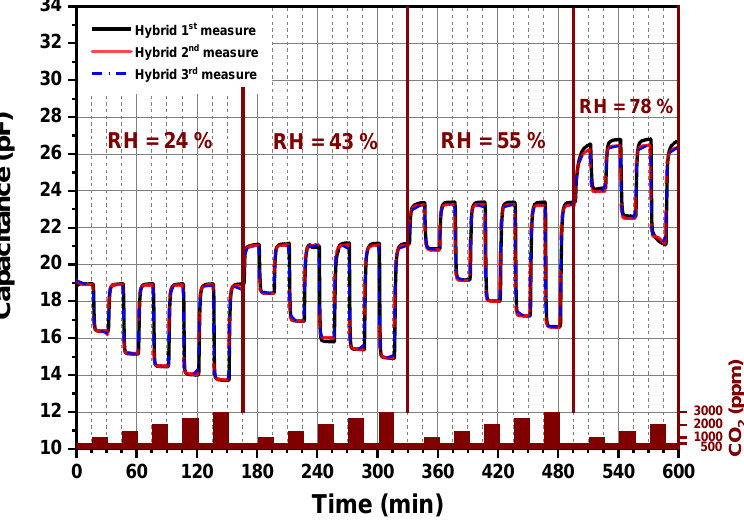
Figure 8. Long-term stability of the CO 2 sensor: Each measurement, 1st, 2nd and 3rd, was performed by heating the sensor to 62 °C over a period of three weeks.